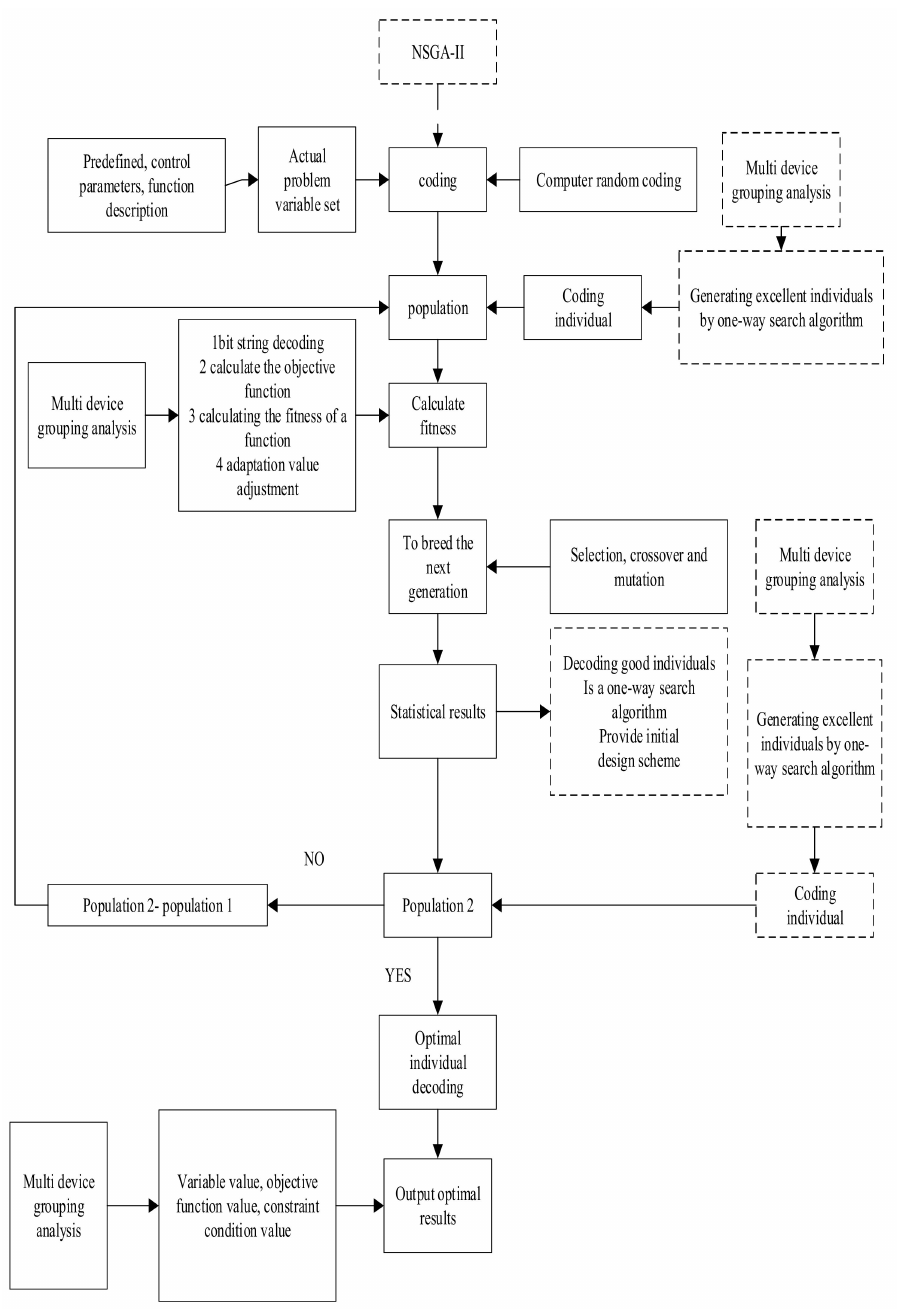
Figure 4. Flow chart for the hybrid